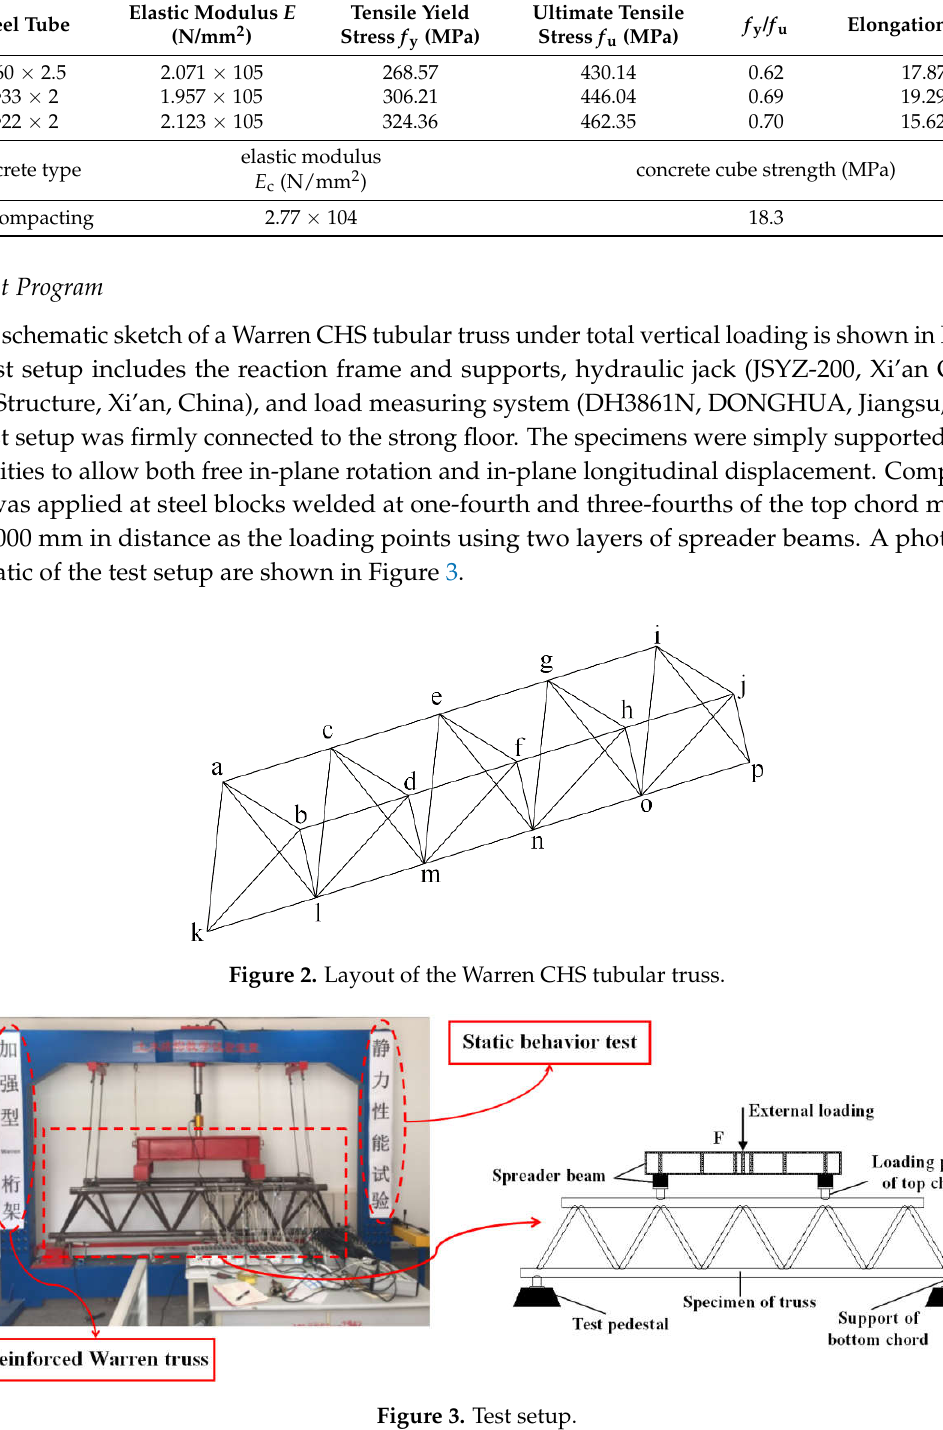
Figure 3. Test setup. Figure 3. Test